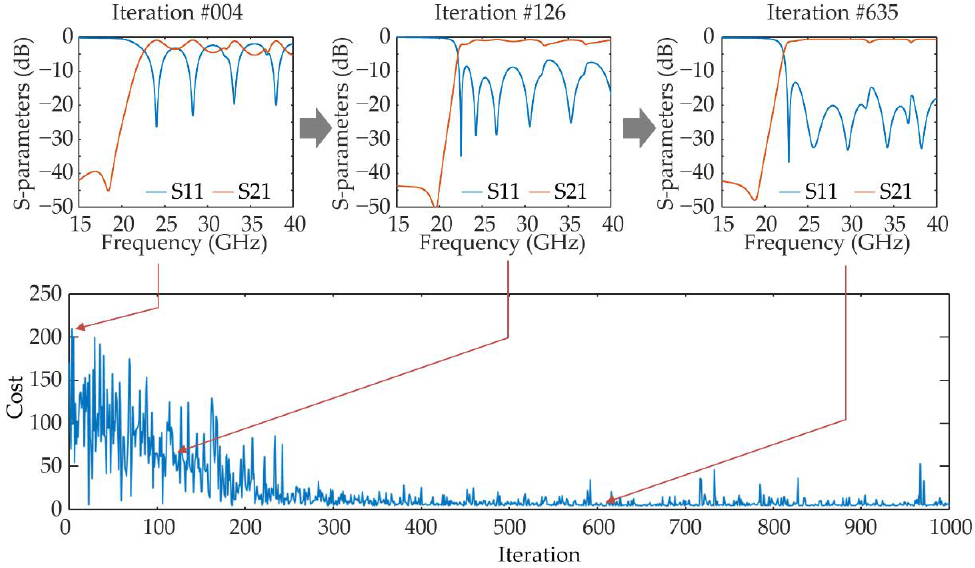
Figure 4. The GA results for the FMSIW with a balanced slot transition show the improvement of the reflection and transmission characteristics.